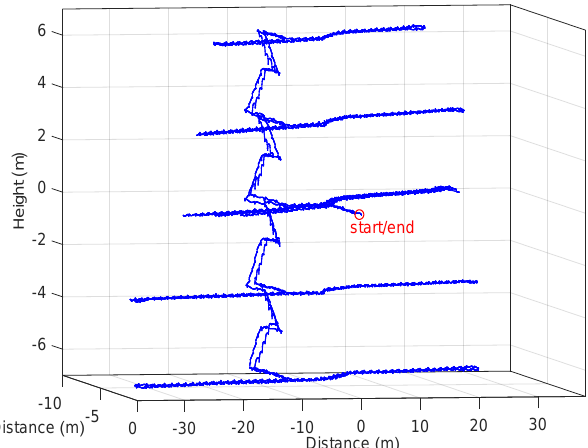
Figure 5. Floor plan of the second floor of the building where the experiments were performed. The trajectory shown in blue is repeated over all floors but the start/end, which is only passed on the second floor. The ground truth points are highlighted in red.